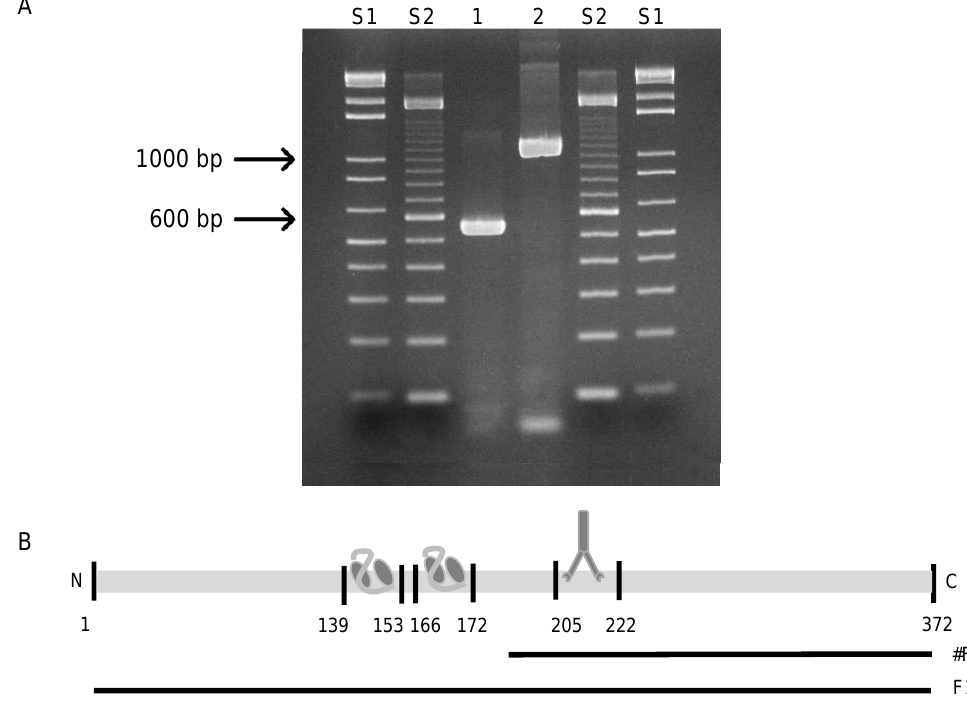
Figure 6. ( A ) Amplification of the 532 bp truncated fragment #1 of F13L VACV (Lane 1) and the 1119 bp F13L gene (Lane 2). S1 and S2 are 1 kb and 100 bp ladders, respectively. ( B ) Schematic illustration of the F13 protein and the truncated fragment #F1. The epitope of the mAb 15B6 is located on the #F1, as well as on the whole F13 protein, while the antigenic sites of the scFv 3E2 are located only on the whole F13 protein.